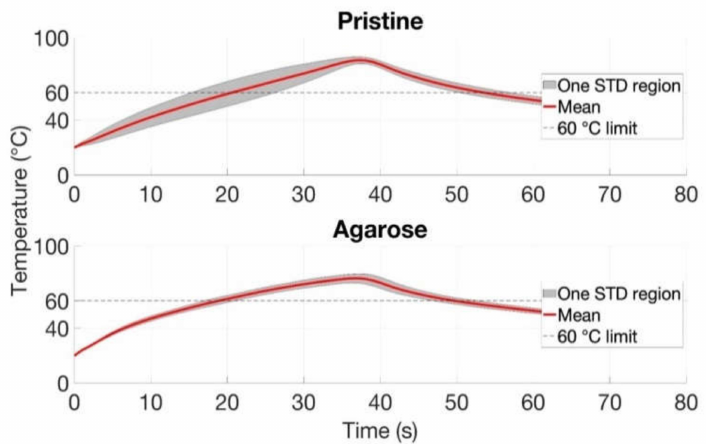
Figure 10. The maximum temperature values achieved during RFA over time in the presence of blood-mimicking system oriented in parallel to AE. The maximum values were reached at 40 s followed by a gradual decrease in both pristine and agarose-administered tissues. The analysis included the mean and standard deviation values evaluated over three trials for each